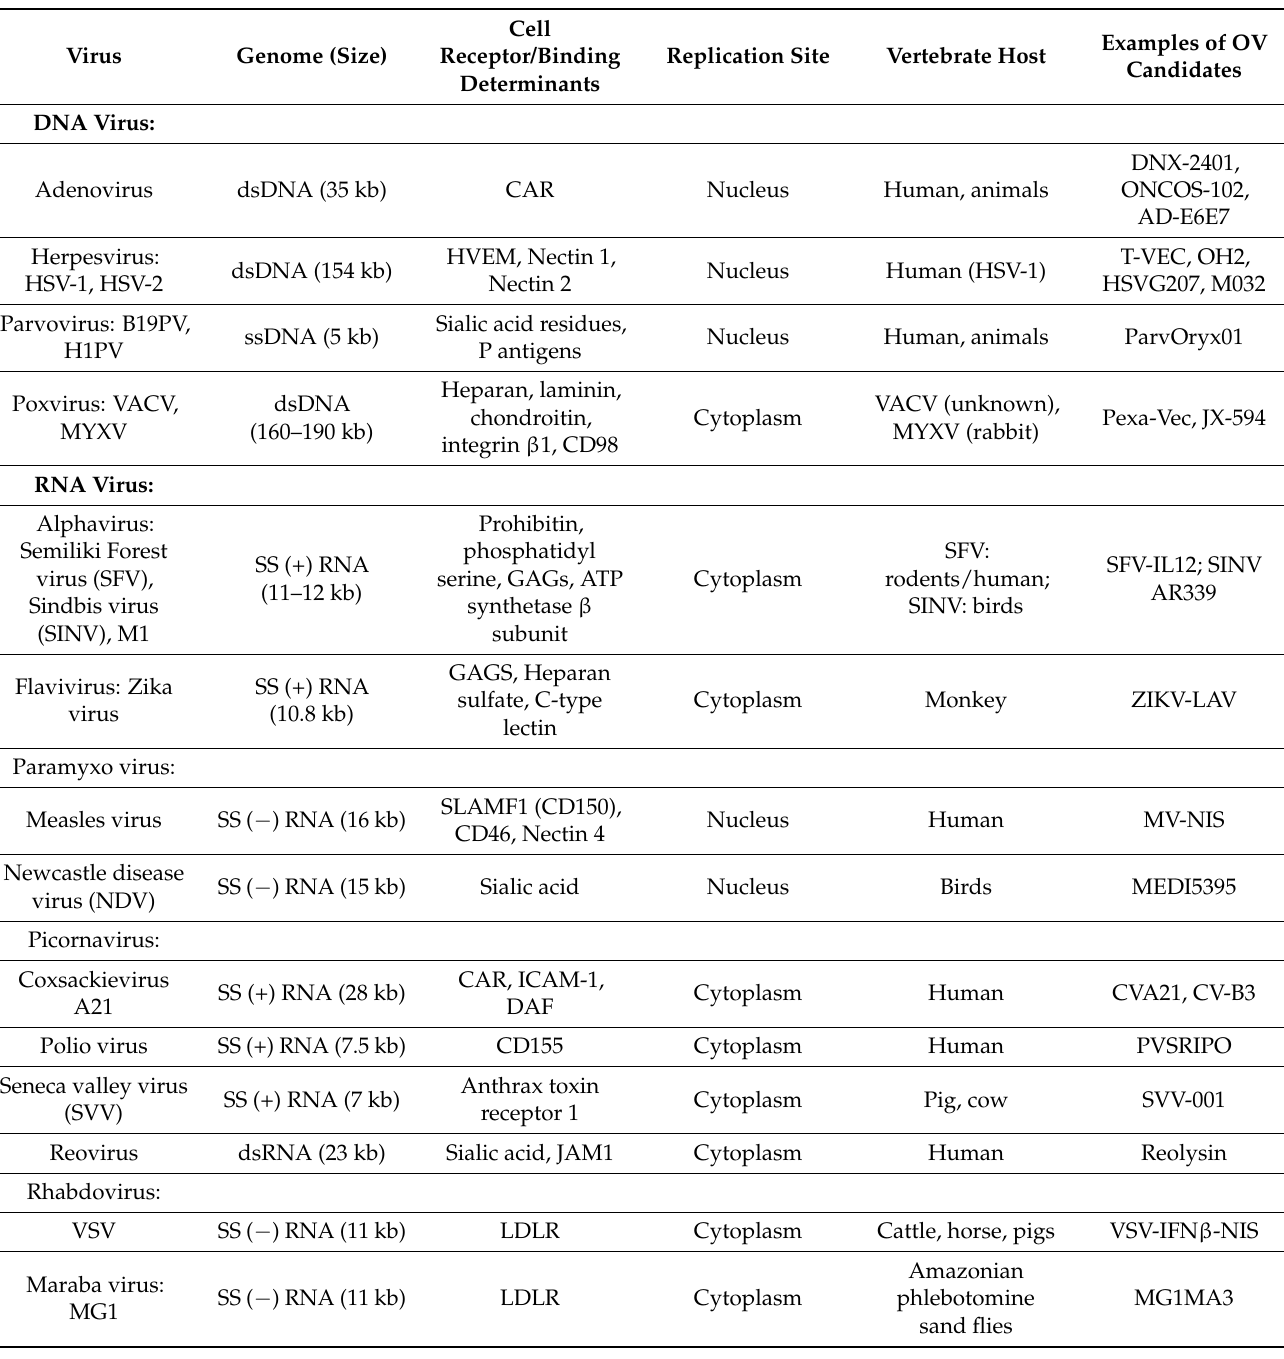
Table 2. List of selected oncolytic